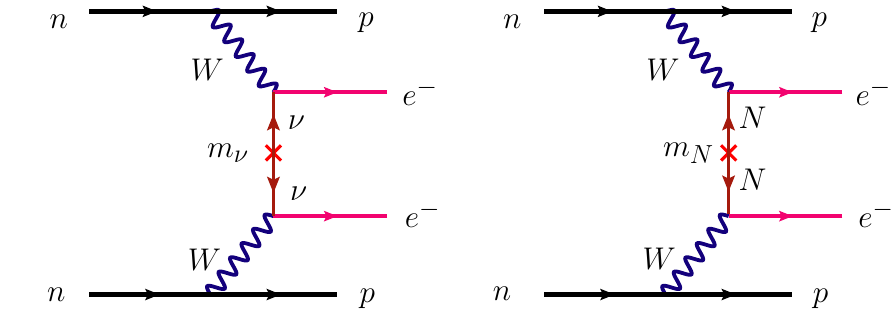
quasi degenerate (QD) pattern is disfavoured from cosmo- logical data from PLANCK1 and PLANCK2. In principle,